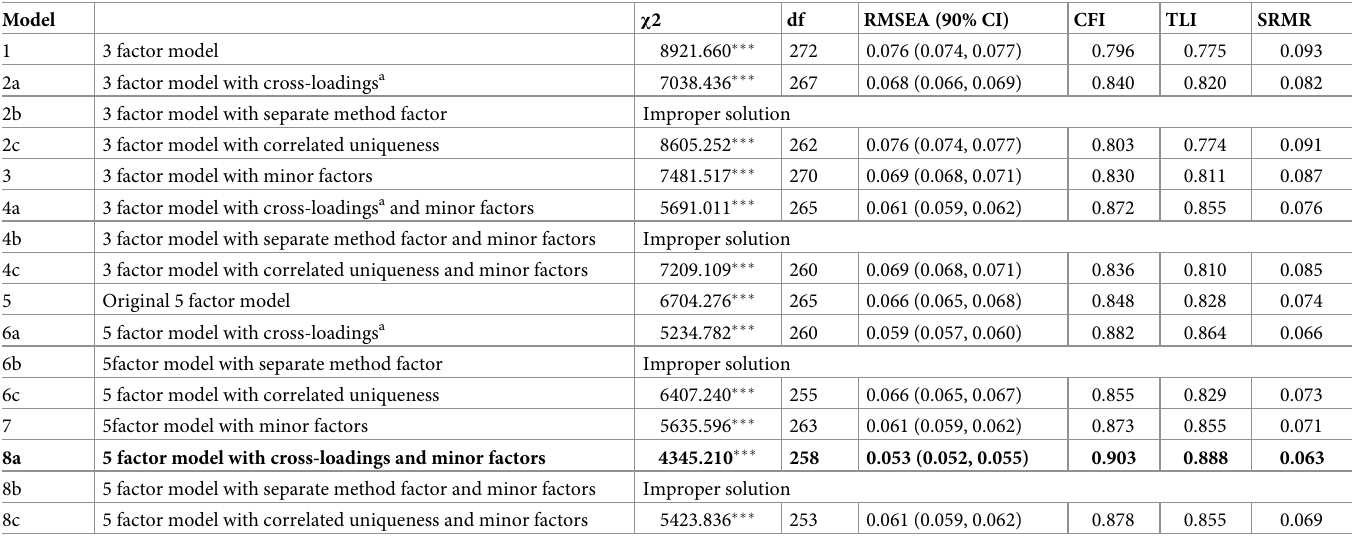
Table 2. Goodness of fit indices for different factor structures of the Strength and Difficulties Questionnaire